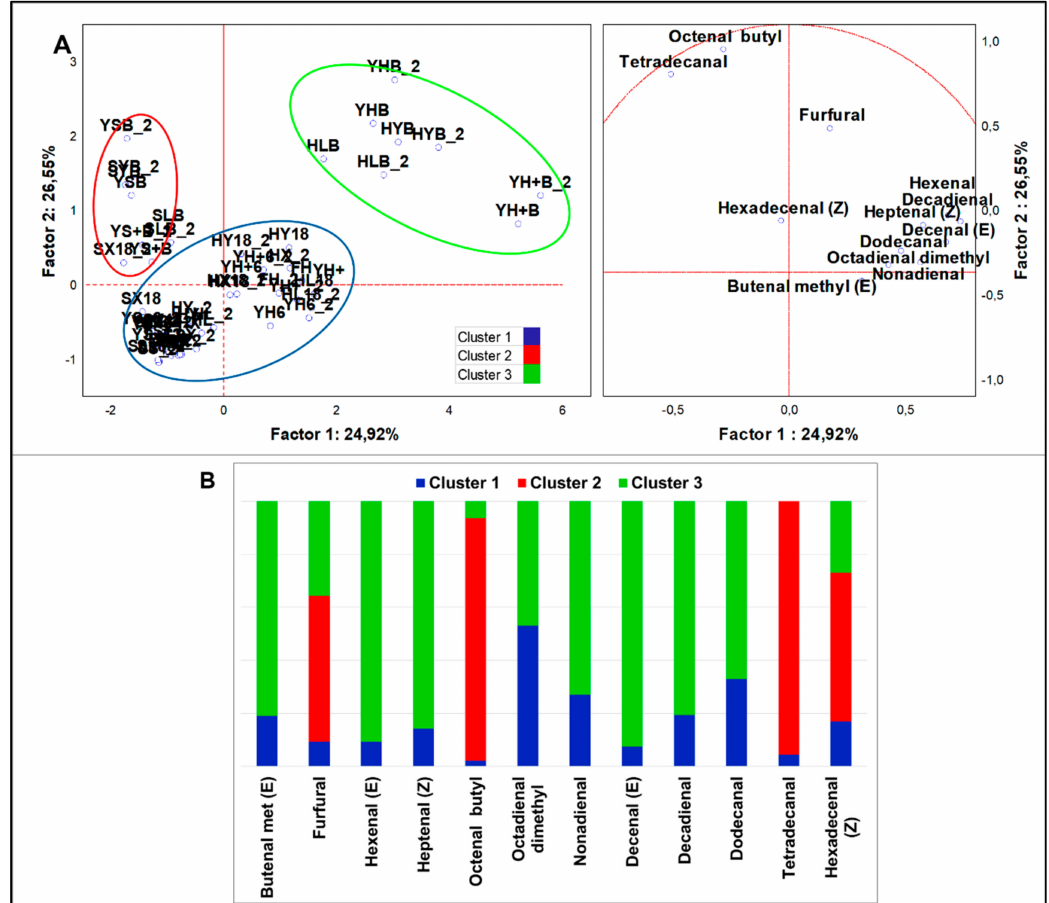
Figure 3. ( A ) PCA of cases and variables on aldehydes ( p < 0.05); ( B ) K-means clustering analysis (at least p <